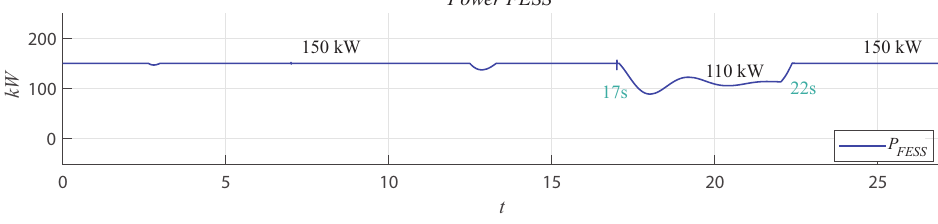
Figure 11. Power absorbed by the FESS for case study 1.